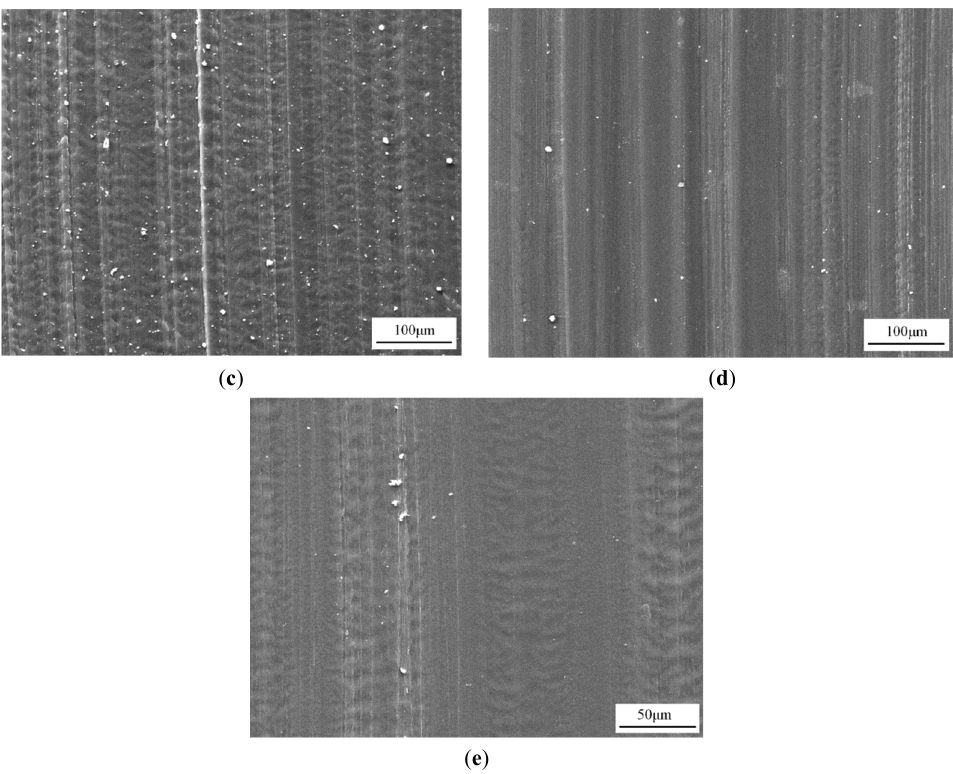
Figure 8. Worn surfaces of UHMWPE discs sliding against Si 3 N 4 -hBN composites in SBF: ( a ) against SN0 pin; ( b ) against SN5 pin; ( c ) against SN10 pin; ( d ) against SN20 pin; ( e ) against SN30 pin.